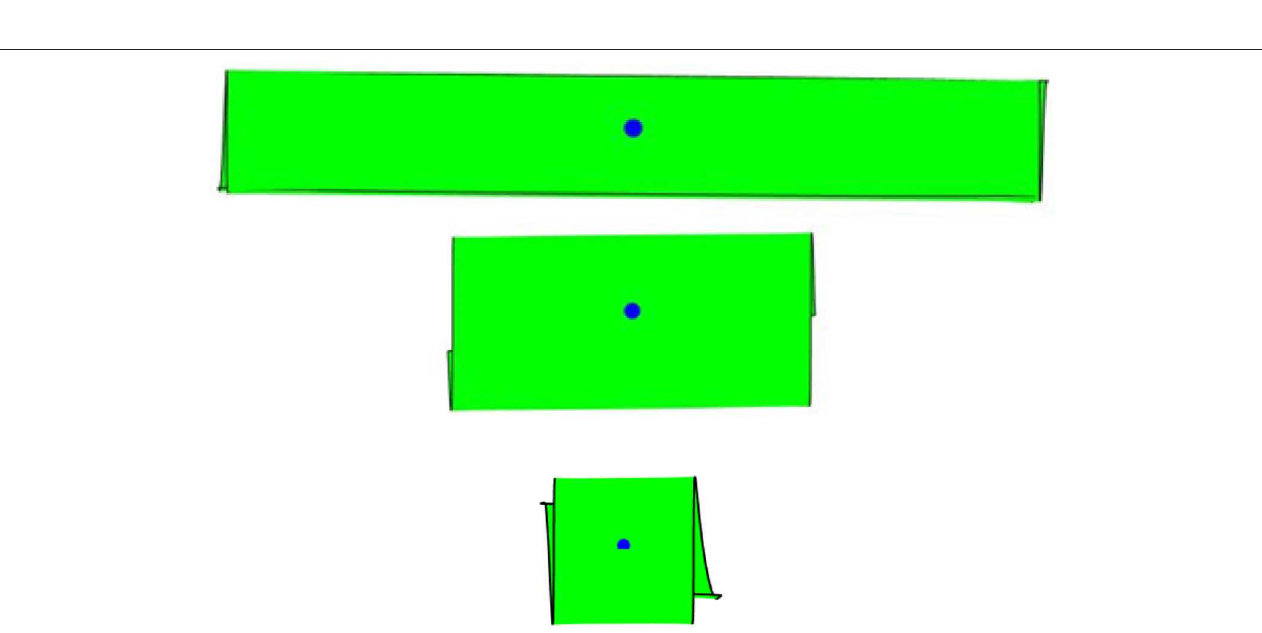
FIGURE 6 | Top view of folded shapes of rectangular plates showing corkscrew shapes.